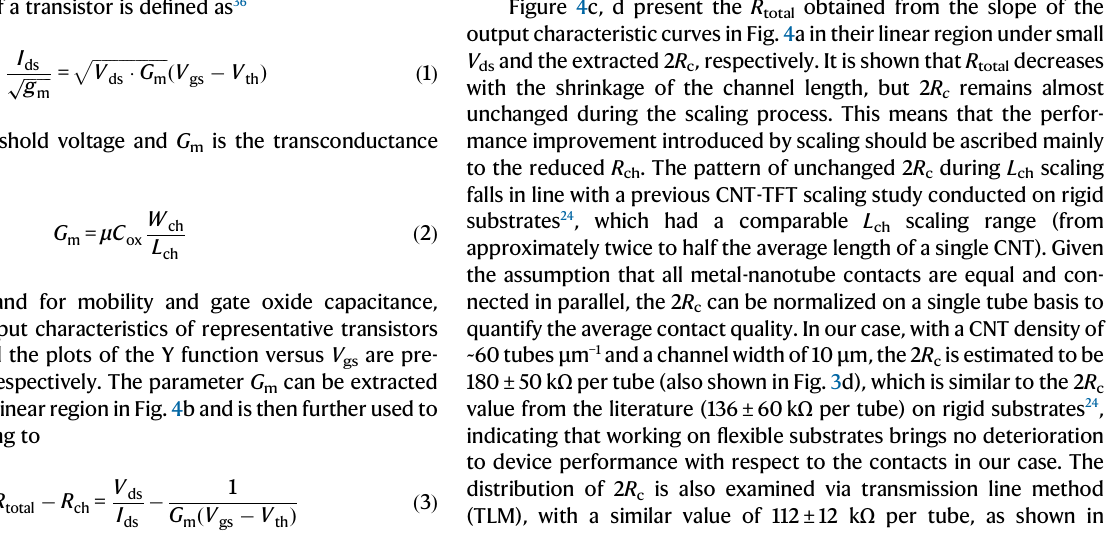
substrates. d Statisticalresults of the current on/off ratiolog ( I on / I off )from devices with different L ch . The upper, middle and bottom bars represent the maximum, average and minimum values, respectively. The upper and lower bands of the boxes represent the 75th and 25th